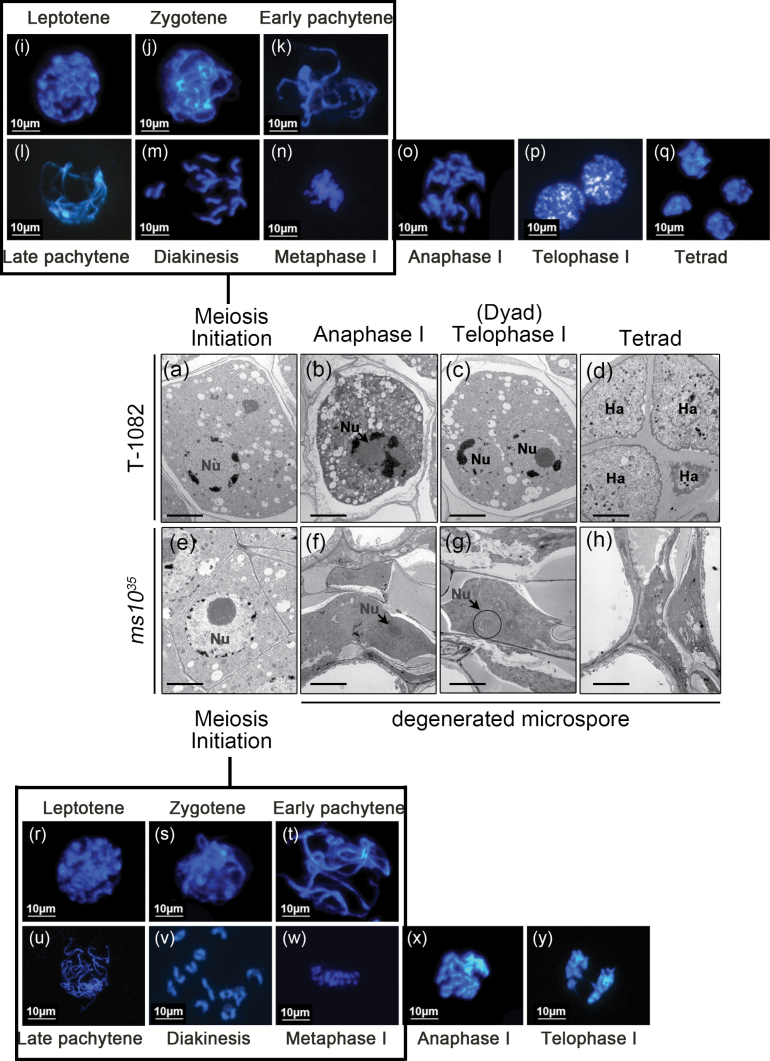
TEM analysis and DAPI staining for observation of meiosis in T-1082 and ms10
35. (A–H) TEM micrographs of meiocyte cells from T-1082 (A–D) and ms10
35 (E–H) anthers at meiosis initiation (A, E), anaphase I (B, F), telophase I (C, G), and tetrad (D, H) stages. At anaphase I, the meiocyte of T-1082 anthers was divided (arrow and white circles, B), while the meiocyte of ms10
35 anthers failed to divide and was diminished (arrow, F). At telophase I (dyad stage), the meiocyte of T-1082 anthers was divided into a dyad (C), whereas the meiocyte of ms10
35 anthers was further diminished (arrow and circle, G). At the tetrad stage, the dyad of T-1082 anthers was divided into tetrads (D), whereas only remnants of the meiocyte remained in ms10
35 anthers (H). Nu, nucleus; Ha, haploid. Bars, 2 μm. (I–Y) Meiotic chromosomes stained with DAPI in T-1082 (I–Q) and ms10
35 (R–Y) at the leptotene (I, R), zygotene (J, S), pachytene (K, L, T, U), diakinesis (M, V), metaphase I (N, W), anaphase I (O, X), telophase I (P, Y), and tetrad (Q) stages. At anaphase I, T-1082 chromosomes were separated to generate two polar sets (O), while ms10
35 chromosomes were aggregated and not segregated clearly (X). At the telophase I stage, T-1082 had generated two different chromosome sets (P), while ms10
35 chromosomes were not segregated clearly and failed to form dyads (Y). At the tetrad stage, T-1082 had generated four tetrahedrally arranged chromosome sets, whereas no tetrad was produced in the ms10
35 mutant. Bars. 10 μm. (This figure is available in colour at JXB online.)